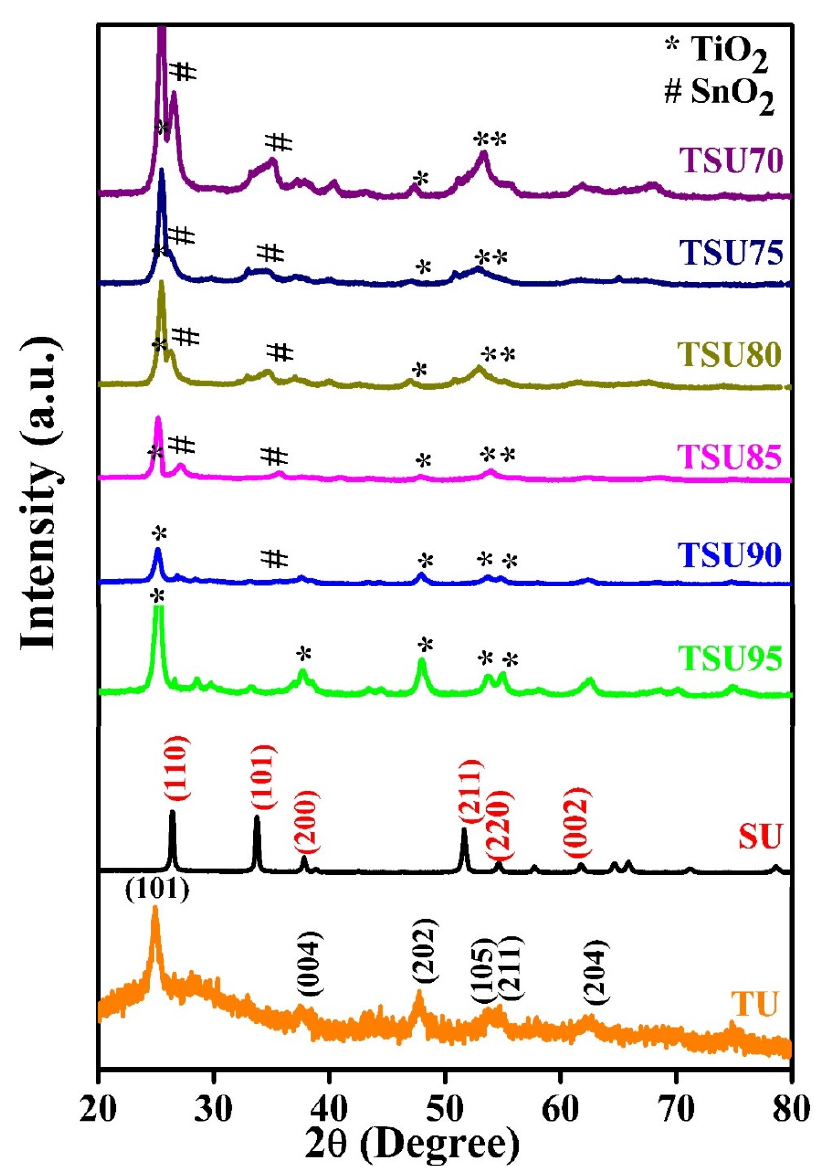
Figure 1. XRD patterns of pure TiO 2 (TU), pure SnO 2 (SU) and TiO 2 –SnO 2 nanocomposites (TSU95,